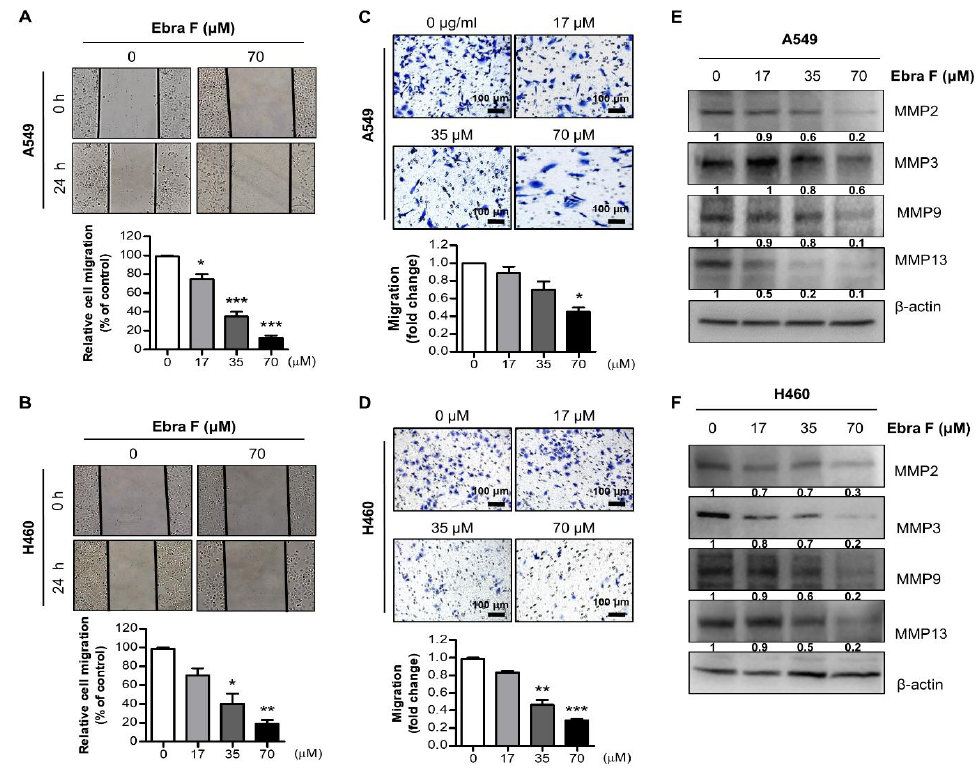
Figure 2. Effect of ebractenoid F on lung cancer cell migration. A wound-healing assay was performed in lung cancer cells after treatment with ebractenoid F for 24 h ( A , B ). A549 and H460 cells were seeded onto 6-well plates, and the confluent cell layer was scratched with 100 µ L tips. Then, the cells were treated with different concentrations of ebractenoid F. The wound closure was monitored under microscope after 24 h and photographs were captured at 0 h and 24 h after wound generation. Then, trans-well assays were performed using A549 and H460 cells ( C , D ). Cells were plated into the gelatin-coated upper chamber of a 24-well format trans-well plate and treated with different concentrations of ebractenoid F. After 24 h of incubation, the migrated cells were stained and photographed under a microscope. The figures representatively show only the results of treatment with ebractenoid F concentrations of 0 and 70 µ M. The data were expressed as the mean ± S.D. of three experiments. *, p ≤ 0.05; **, p < 0.01; ***, p < 0.001; n.s. (not statistically significant) indicates statistically significant differences from the control group. The expression levels of migration-associated proteins were determined by Western blot analysis using antibodies against MMP2, MMP3, MMP9, MMP13, and β -actin (internal control). Each band is representative of three experiments ( E , F